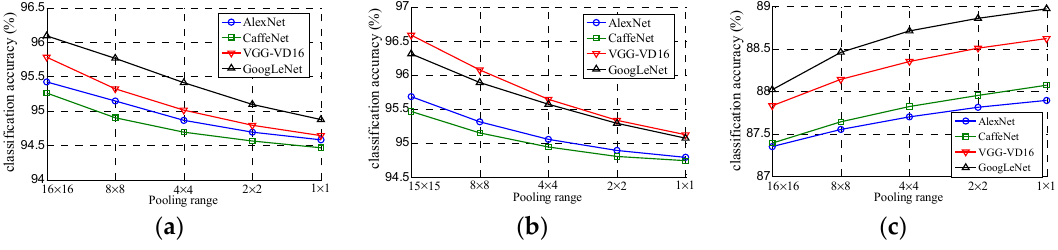
Figure 16. Accuracy of remote scene classification on: ( a ) UC Merced dataset; ( b ) WHU-RS dataset; and ( c ) Brazilian Coffee Scenes dataset in condition of various pooling ranges in LQPCANet in Architecture (II).